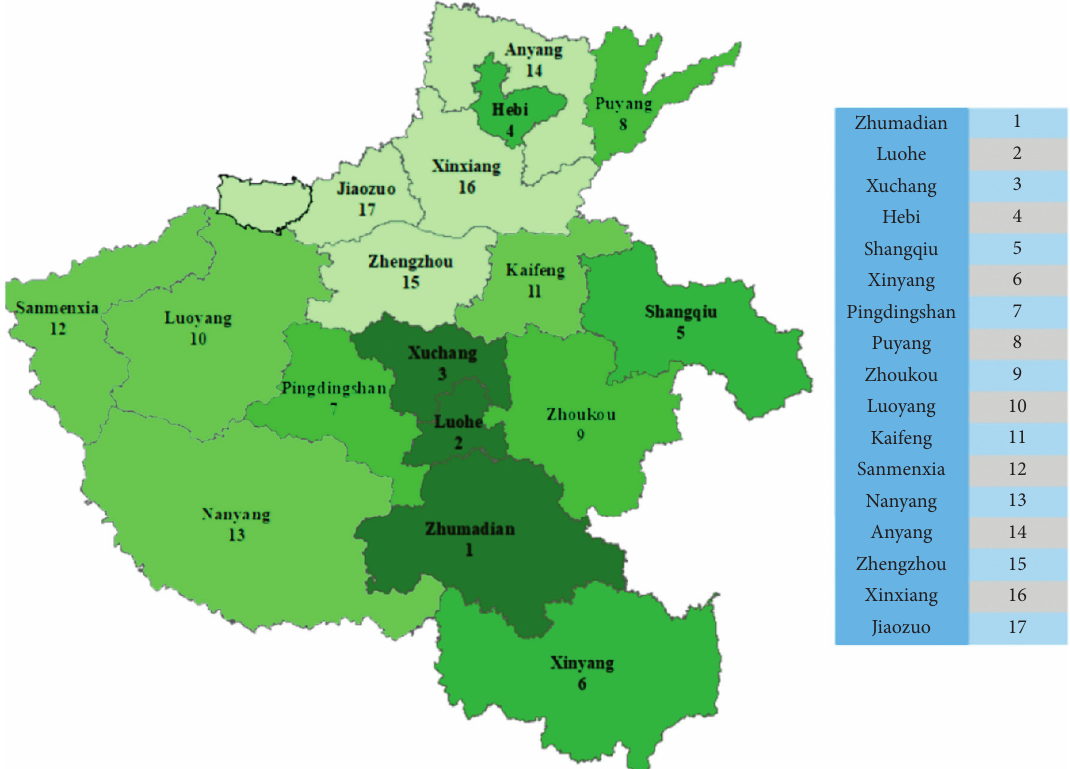
Figure 8: The comprehensive ranking of the sustainable development of cities in Henan Province in the environmental